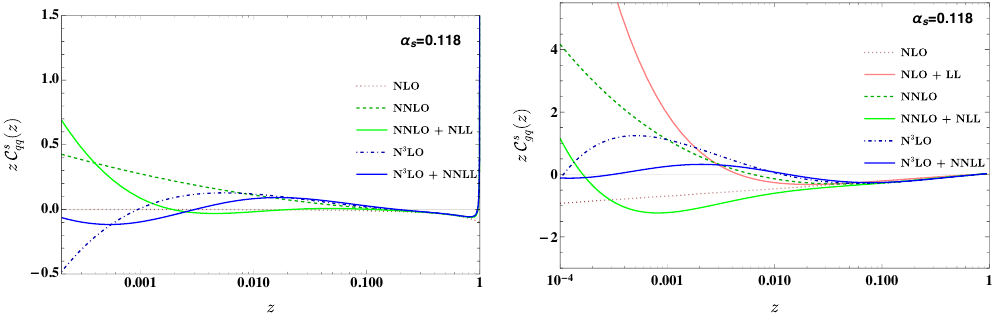
Figure 1 . Coefficient functions for quark TMD FFs. Shown in the plots are fixed-order results at NLO, NNLO and N 3 LO, as well as adding the higher-order resummation contributions truncated to order α 15 s